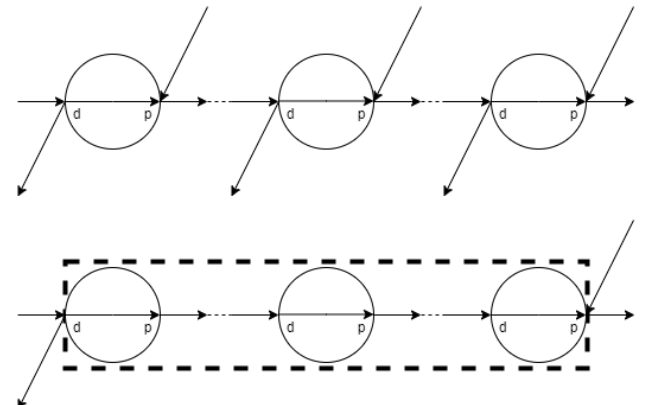
Figure 2. Pre-grouping of machine stations just after network construction ( top ) and post-grouping (alongside removal of extraneous arcs) for model simplification ( bottom ).